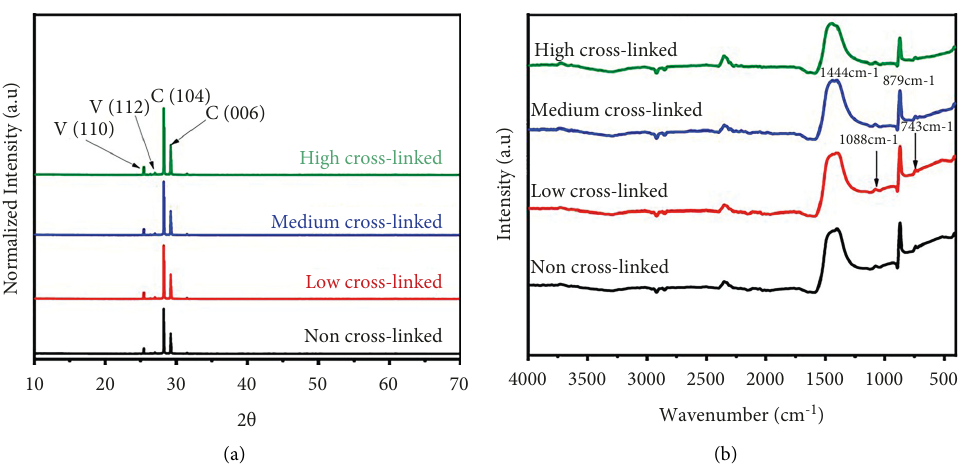
Figure 5: (a) XRD patterns and (b) FT-IR obtained from all cross-linked samples of PAH/PAMAM